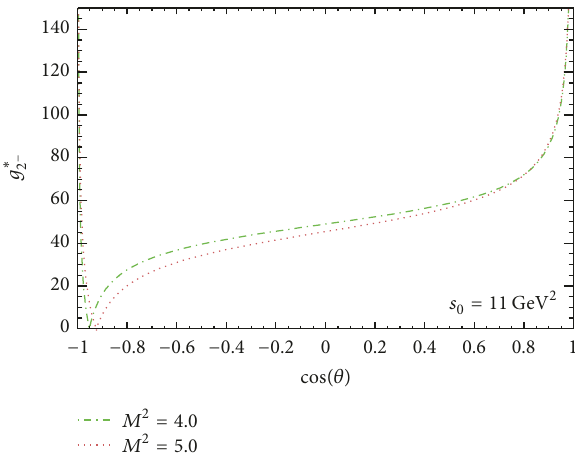
Figure 4: Same as in Figure 2, but for scenario (b).